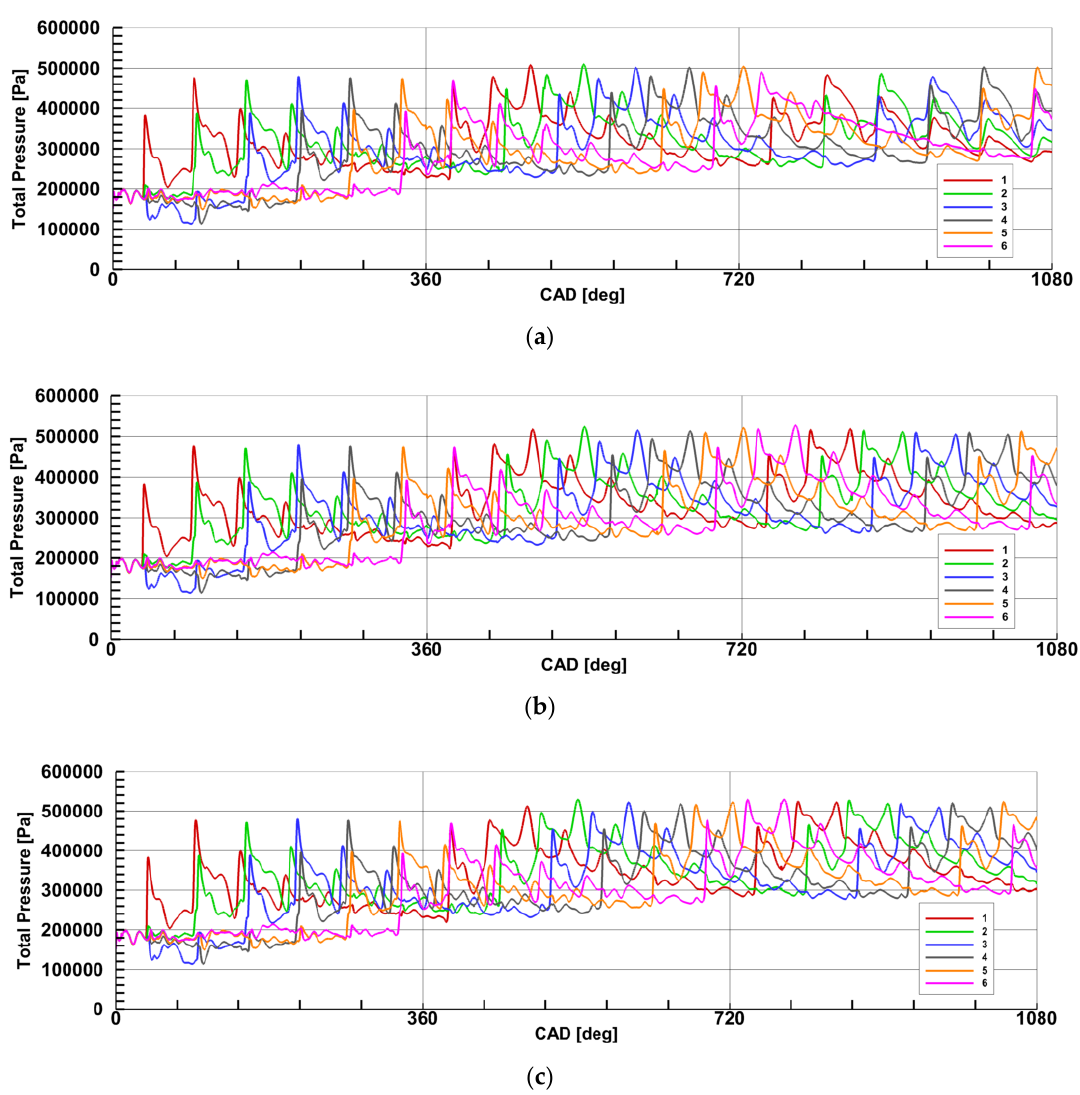
Figure 7. The mass flow average pressure variations at the turbine inlet at: ( a ) n = 40,000 rpm; ( b ) n = 50,000 rpm; ( c ) n = 60,000 rpm.